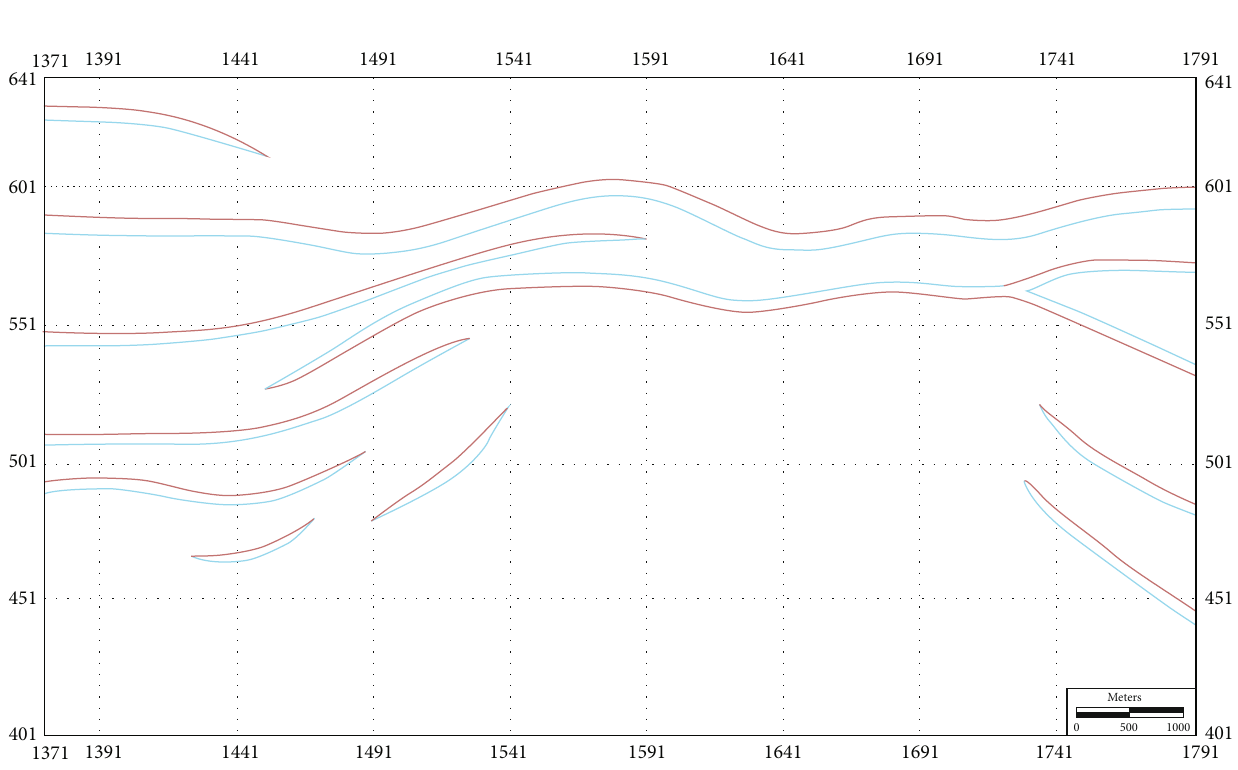
Figure 3: T0 re fl ector plane fracture system.